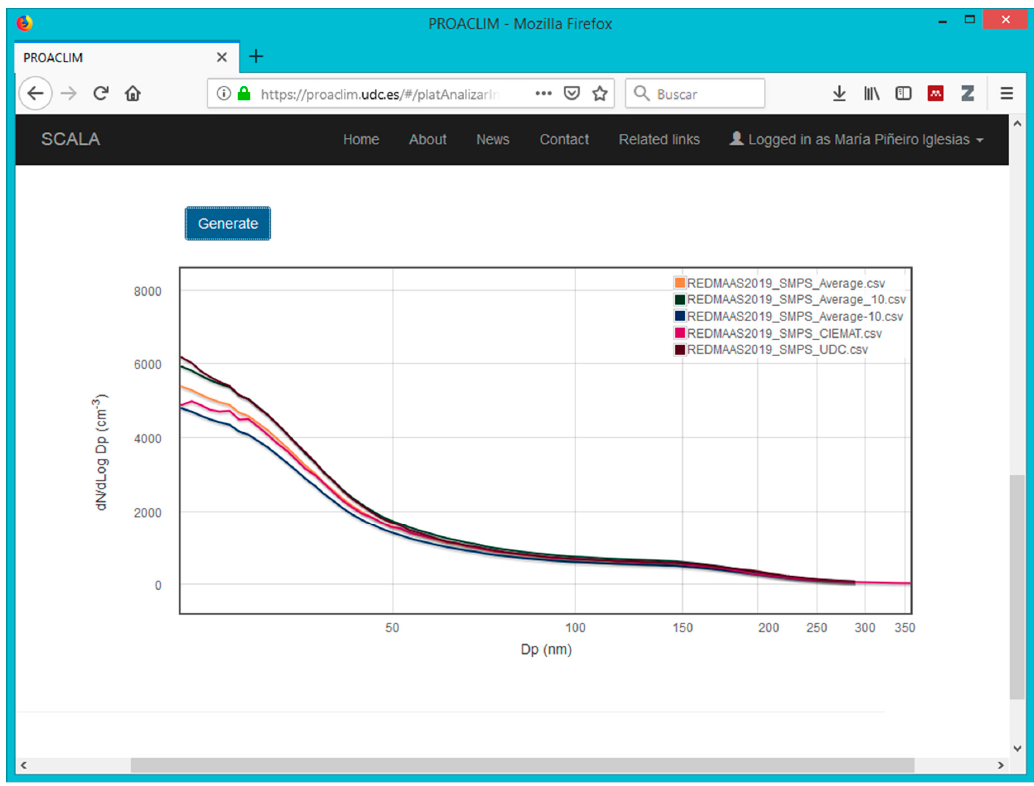
Figure 6. dN/dLog dp (cm − 3 ) vs. dp (nm) for the SMPS intercomparison during REDMAAS2019. Figure 6. dN / dLog dp (cm − 3 ) vs. dp (nm) for the SMPS intercomparison during REDMAAS2019. Atmosphere 2019 , 10 , x FOR PEER REVIEW